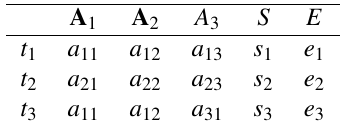
Table 2. Sample database containing the instance r of the valid- time relation R .